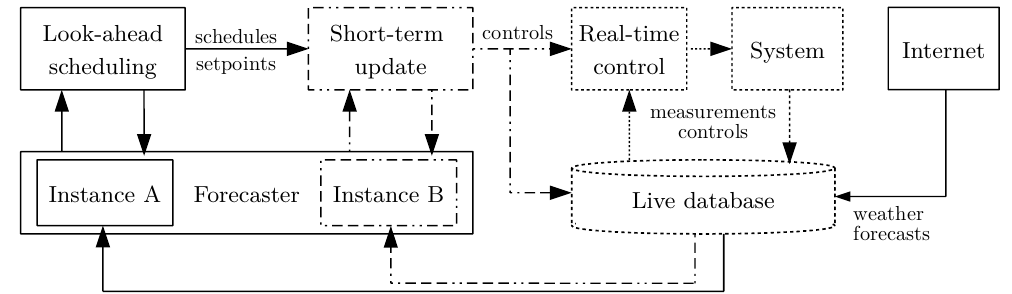
Figure 13. Optimization scheme adopted from [24] as implementation of the general concept presented in Figure 1. Solid lines indicate low frequency data flow belonging to look-ahead schedule computations, dashed-dotted lines data flow used by short-term updates, and dotted lines data flow which is only visible to and used by real-time control, actuators, and